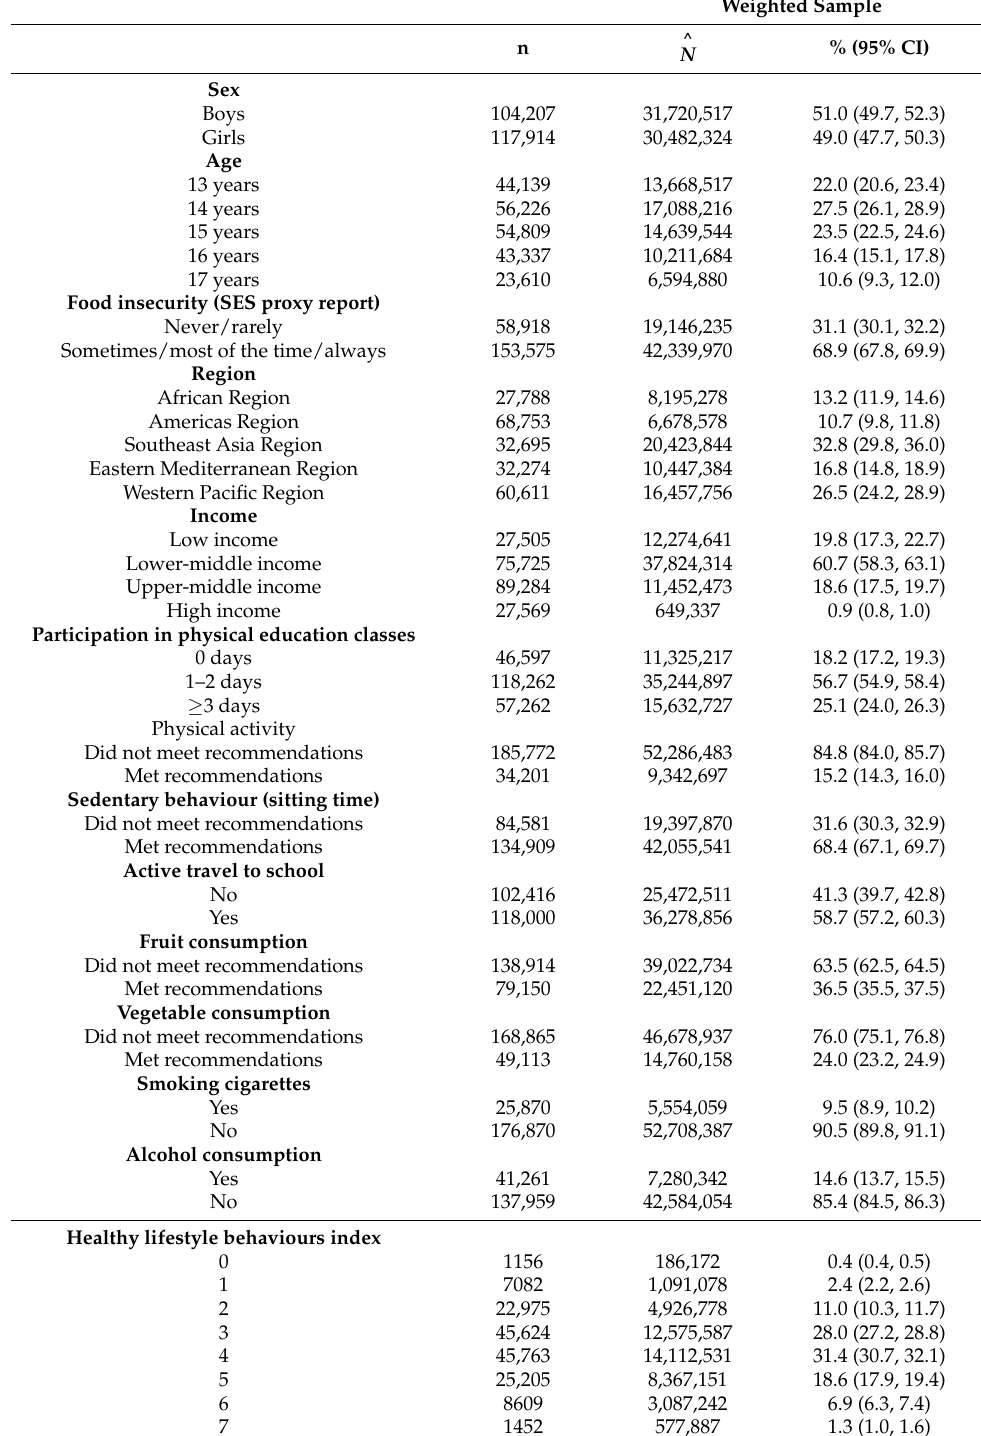
Table 1. Participants’